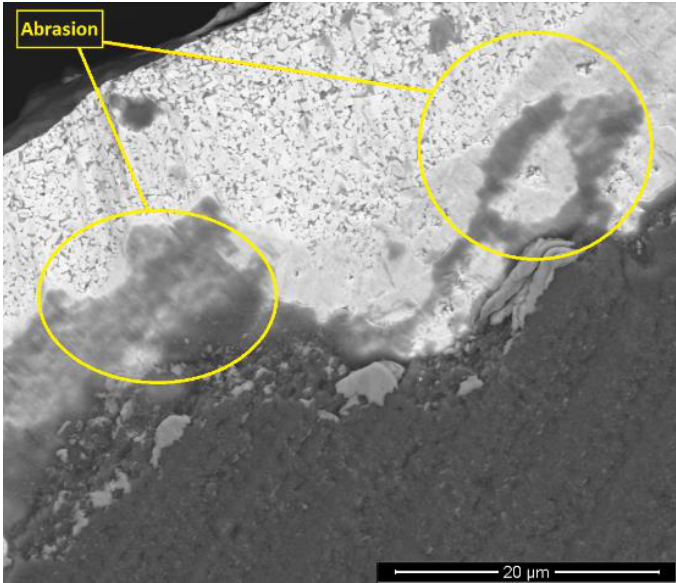
Figure 18. Abrasion marks detected on T4 tool’s rake face, tested at 125% feed rate.